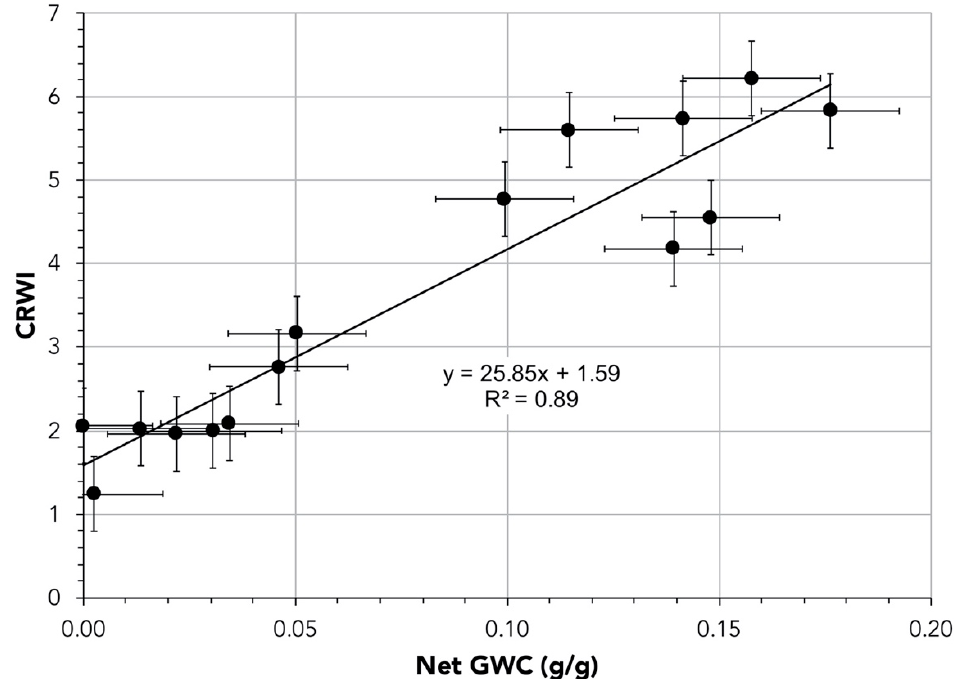
Figure 6. Calibration curve for relating ground truth soil moisture content to ground truth continuum removed water index (CRWI). p < 0.001.